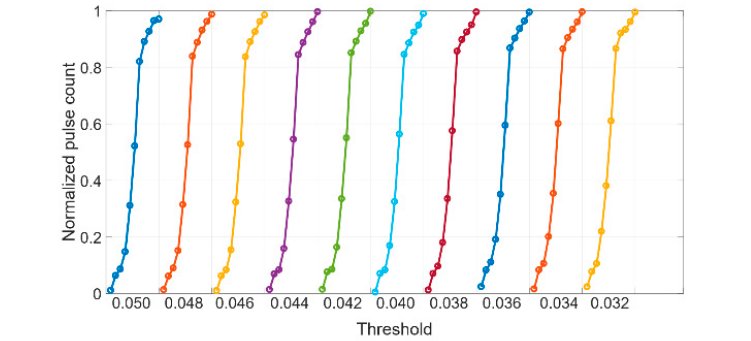
Figure 6. Diagram of pulse count before and after normalization with different thresholds as a function of stress.